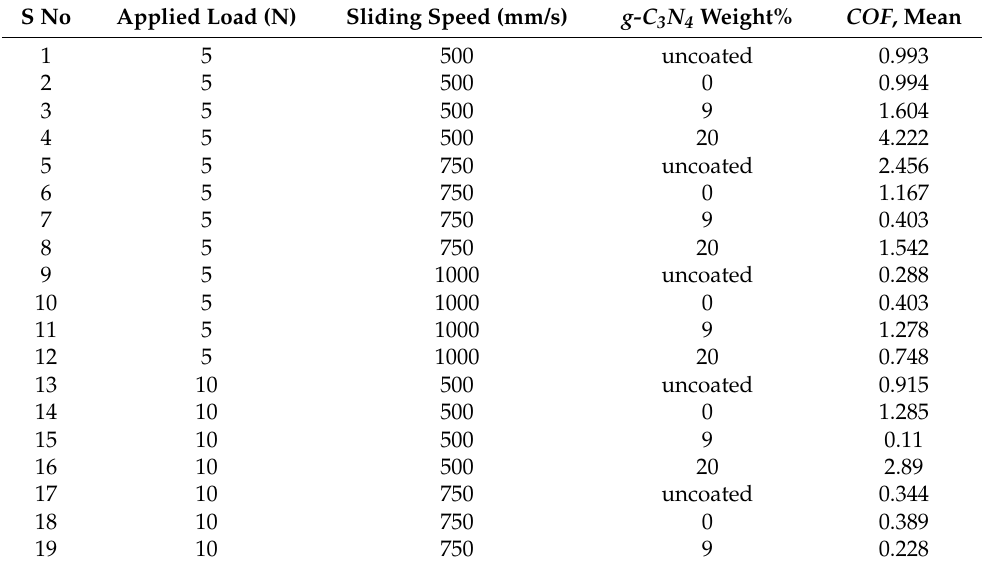
Table 5. Mean coefficient of friction for different combinations of